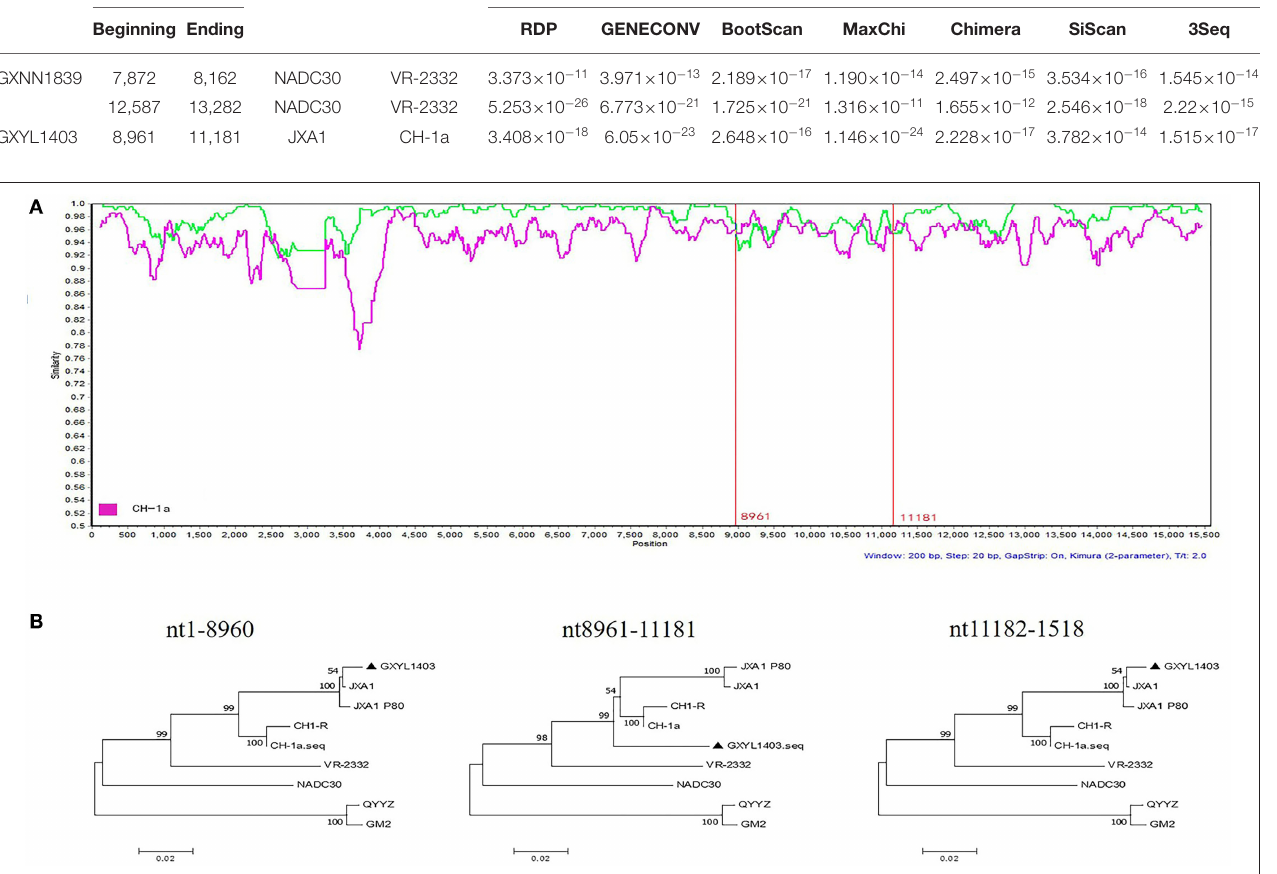
TABLE 4 | Recombination breakpoints identified in GXYL1403, GXNN1839, and associated parental strains of PRRSV. Isolate